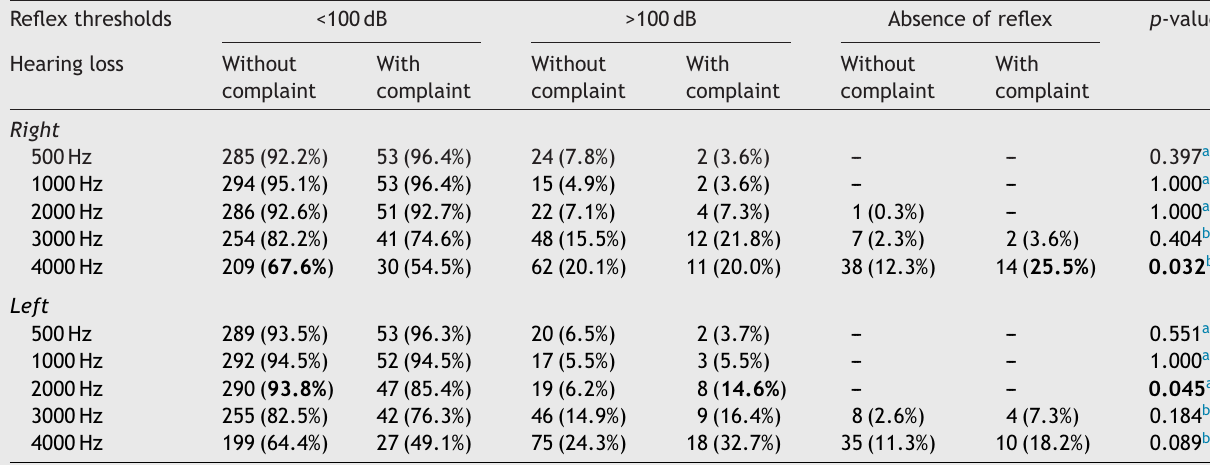
Comparison between hearing loss complaints and contralateral stapedial reflex thresholds ( n = 364). Reflex thresholds